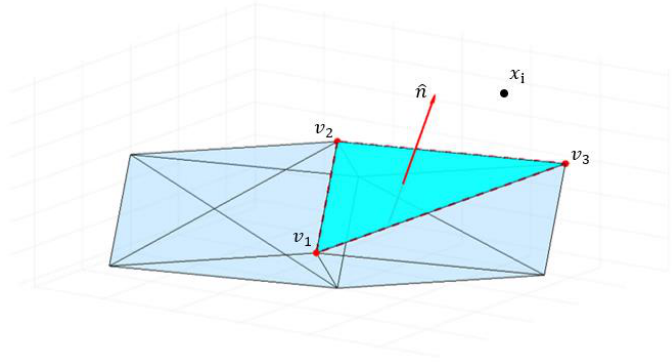
Table 1. Confidence level of scaled SDE for different scaling factors and dimensions